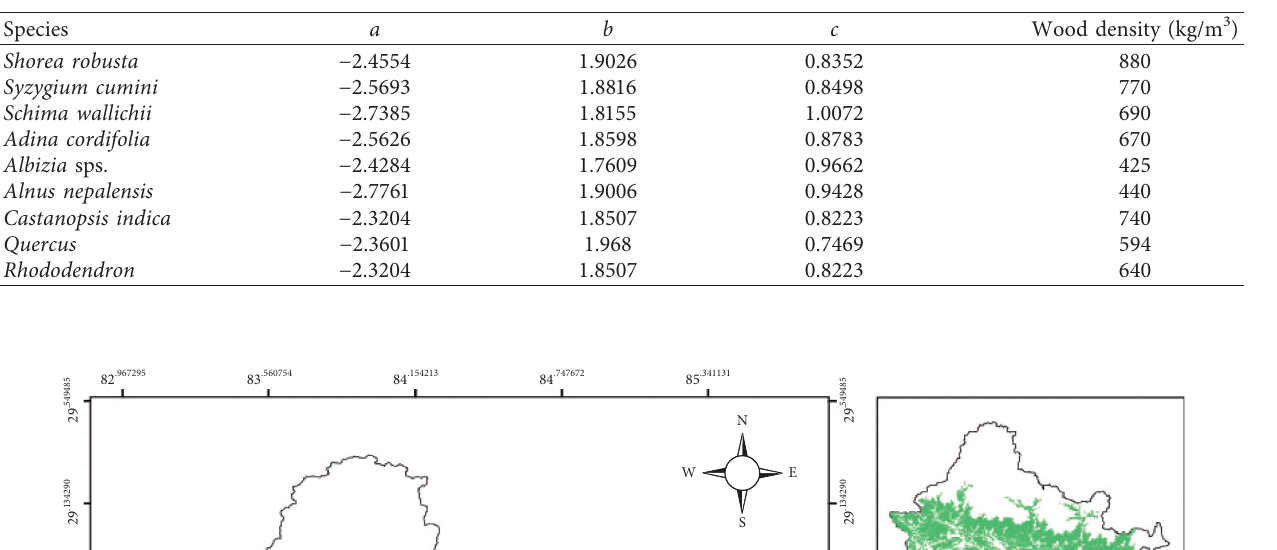
Table 1: Model parameters and wood density of major trees.